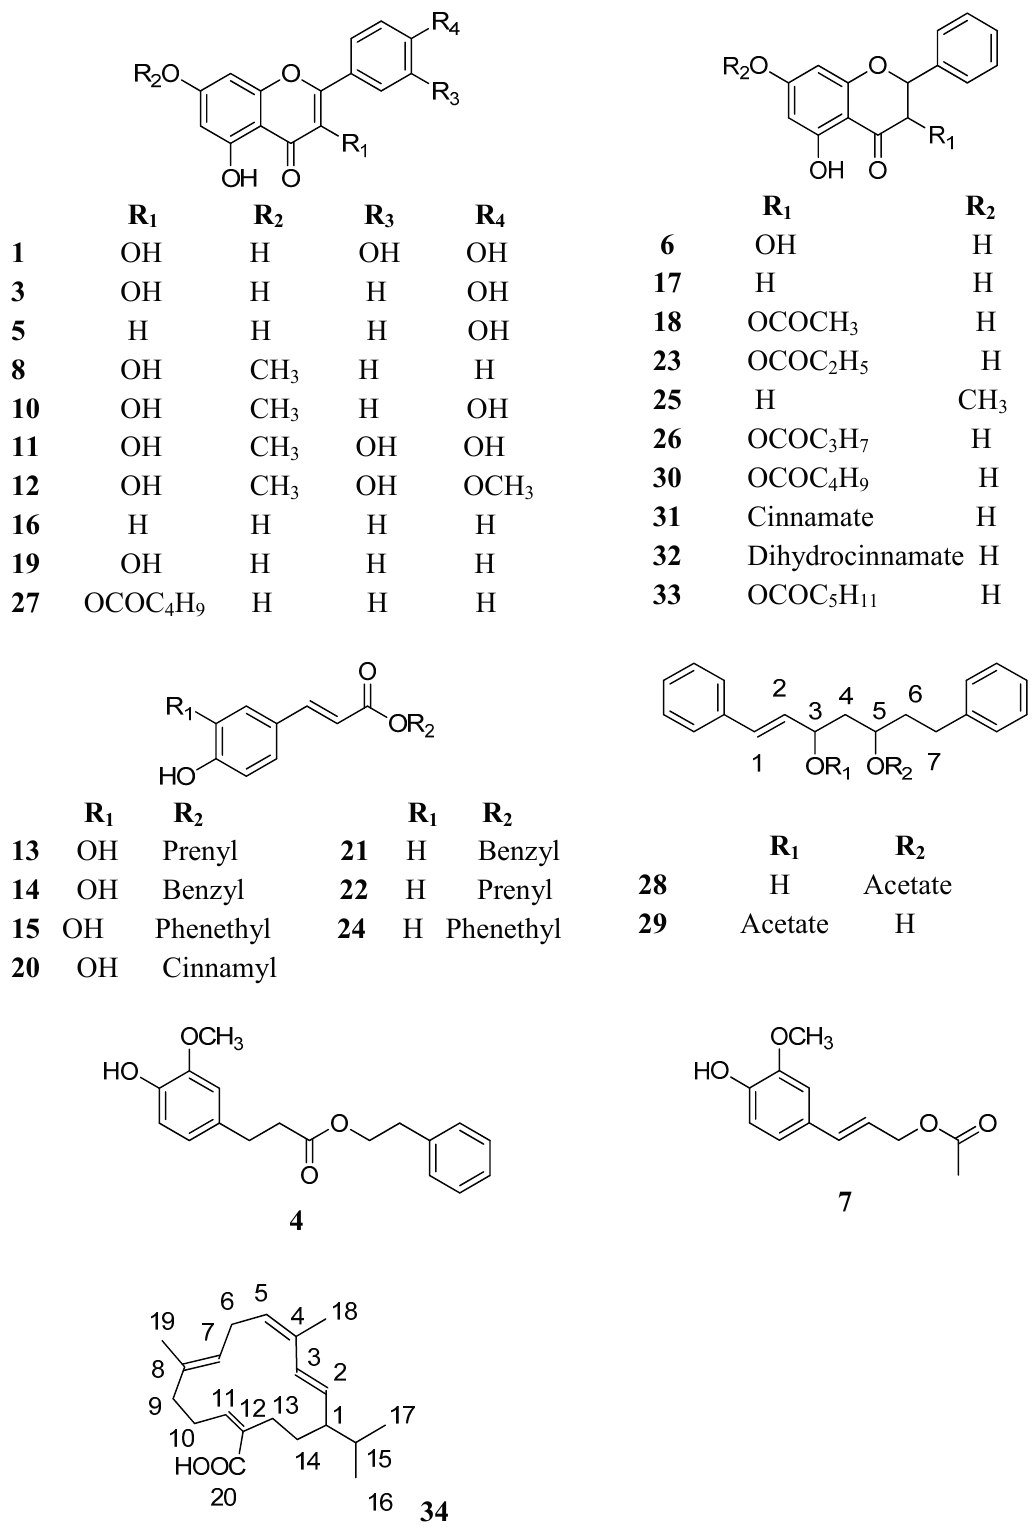
Figure 4. Structure of the compounds identified/tentatively identified in propolis from the Región del Maule, central